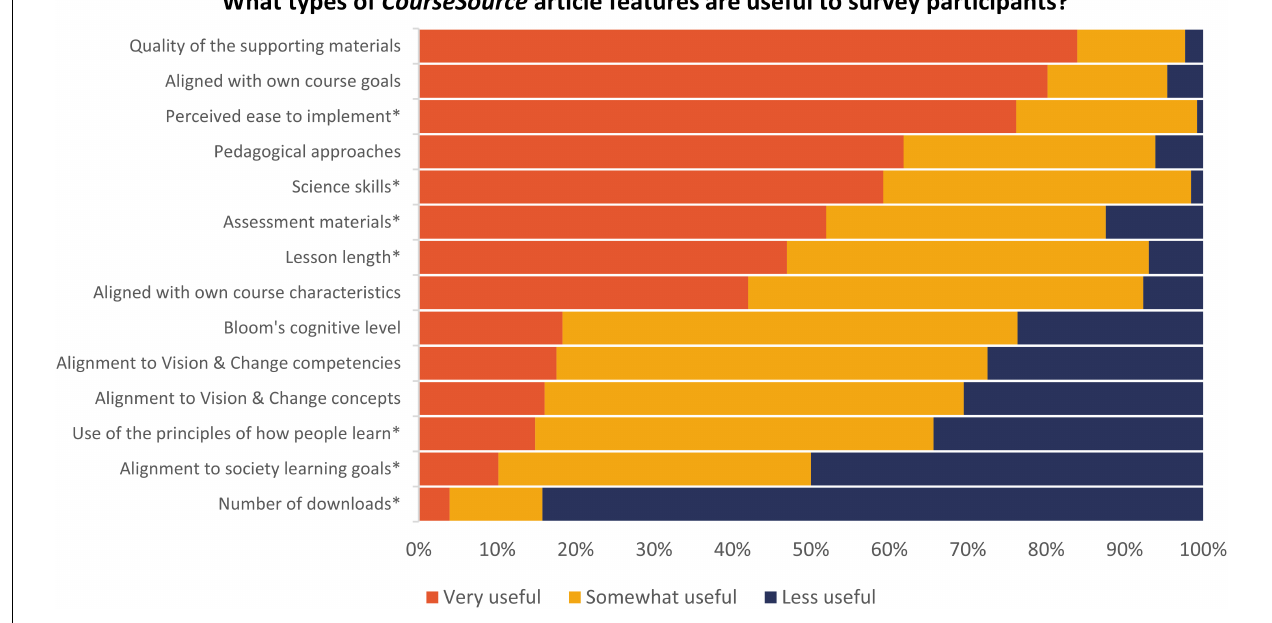
FIGURE 5 | Survey participants’ Evaluation of resources. The bars illustrate the usefulness of different CourseSource lesson article features. Descriptions of the learning frameworks are in the “Materials and Methods” section. ∗ Indicates that one or two survey participants did not select a level of usefulness for the particular article component.